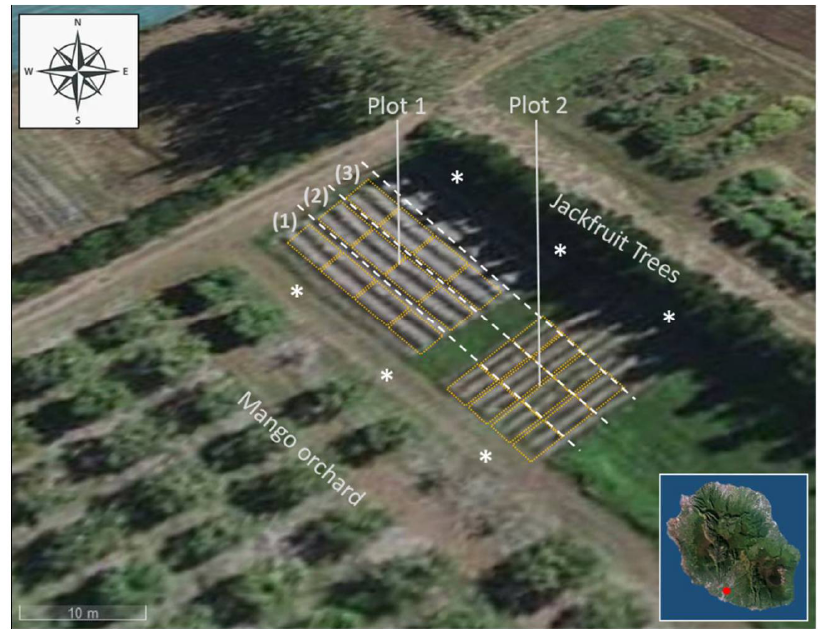
Figure 1. Environmental context of pineapple plots located in Reunion Island. Plot 1: North-West/South-East-directed rows; Plot 2: South-West/North-East-directed rows. (1) Plot sections proximal to the mango orchard, (2) central section of the plots, and (3) plot sections near the jackfruit trees. Quadrats are shown as yellow rectangles. White asterisks indicate coring points.